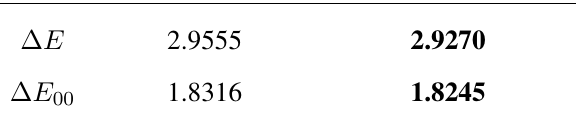
Table 3. Comparison between matrix sampling and spherical sampling as the mean for all the cameras, illuminants and